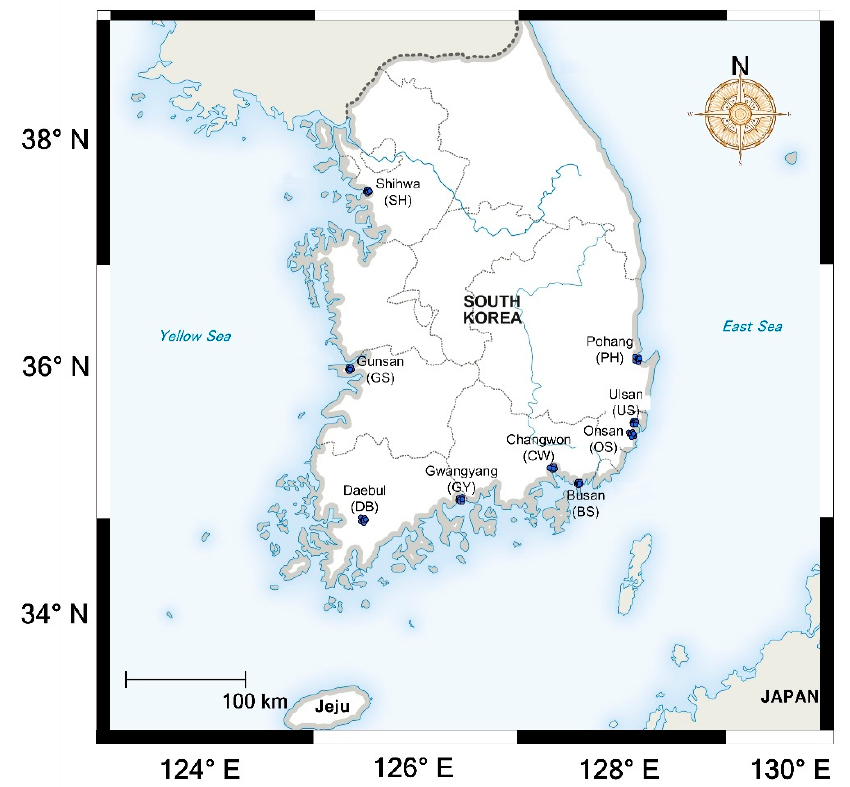
Figure 1. Map and sampling stations of nine industrial complexes where RDS was collected in this study. PM10 samples from in this study were separated from bulk RDS samples of our previous study [44]. More detailed information of the study area can be obtained from the previously reported study [44].